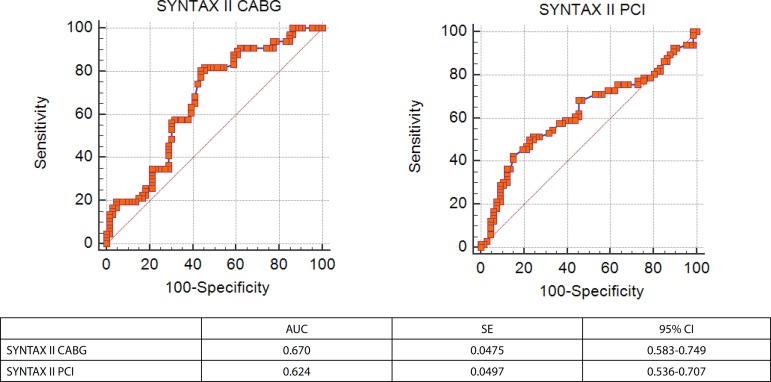
ROC curve analysis of SYNTAX II CABG and PCI for prediction of significant carotid artery stenosis. 95% CI=95% confidence interval; AUC=area under the curve; CABG=coronary artery bypass grafting; PCI=percutaneous coronary intervention; SE=Standard error